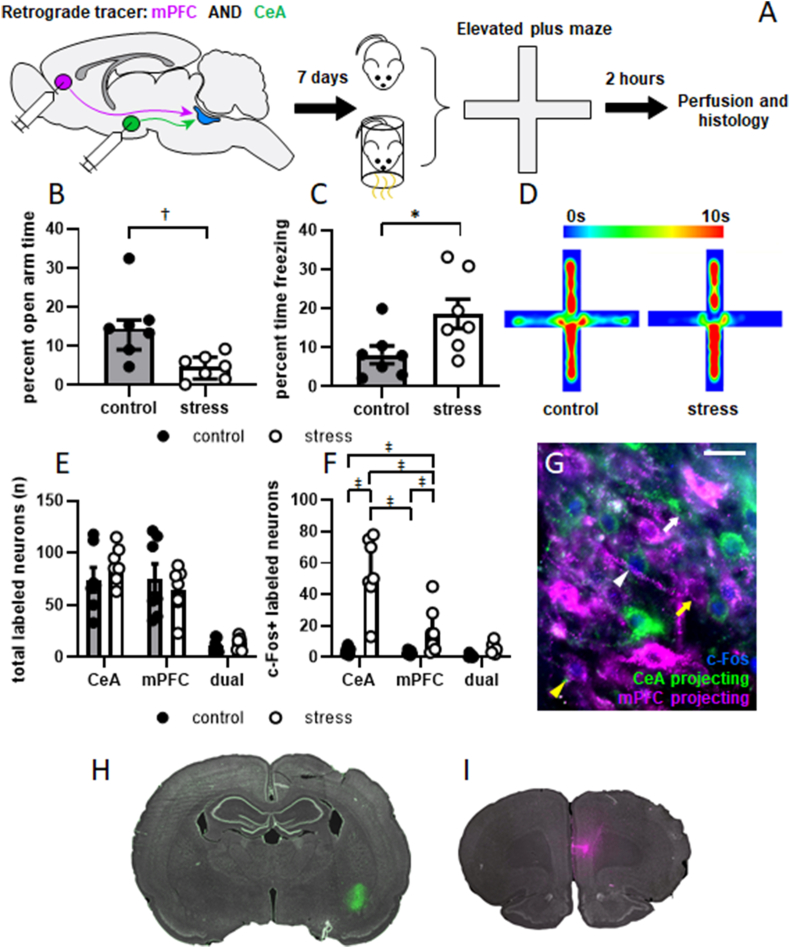
Acute stressor exposure increases anxiety-like behavior and c-Fos expression in LC neurons projecting to CeA. The experimental timeline is shown in A. Animals underwent a surgical procedure to inject two distinct retrograde tracers in mPFC (red; shown in magenta) and CeA (green). Seven days later, they underwent stressor exposure (n = 7) or control conditions (n = 7). Behavior was then assessed in the EPM, and 2 h later rats were sacrificed for immunofluorescent detection of c-Fos in LC. Time spent in the open arms was square-root transformed to satisfy requirements for parametric statistical testing and was significantly decreased in stressed rats (gray bars with filled circles) relative to control rats (white bars with open circles; B; shown as median with interquartile range). Stressed rats also spent more time freezing than control rats (C). Mean heat maps for behavior in the EPM are shown in D. Injections of retrograde tracers resulted in similar numbers of labeled cells projecting to mPFC and CeA regardless of treatment. The number of double labeled cells projecting to both regions (dual) was small (E). The number of c-Fos positive nuclei was logarithm transformed to satisfy requirements for parametric testing, and was found to significantly increase in both the LC→CeA and LC→mPFC projections in response to stressor exposure. However, the number of c-Fos positive nuclei was significantly greater in the LC→CeA projection than LC→mPFC projection in stressed animals (F; shown as median with interquartile range). A representative photomicrograph of labeled neurons in the dorsal third of LC is shown in G. LC→mPFC neurons are magenta, LC→CeA neurons are green, and c-Fos is shown in blue. White arrowhead and arrow indicate examples of c-Fos+ and c-Fos- LC→CeA neurons, respectively. Yellow arrowhead and arrow indicate examples of c-Fos+ and c-Fos- LC→mPFC neurons, respectively. Scale bar = 25 μm. Representative images of injection of tracers into CeA and mPFC are shown H and I, respectively. *: p < 0.05. †: p < 0.05 after square root transformation. ‡: p < 0.05 after logarithm transformation. (For interpretation of the references to colour in this figure legend, the reader is referred to the Web version of this article.)